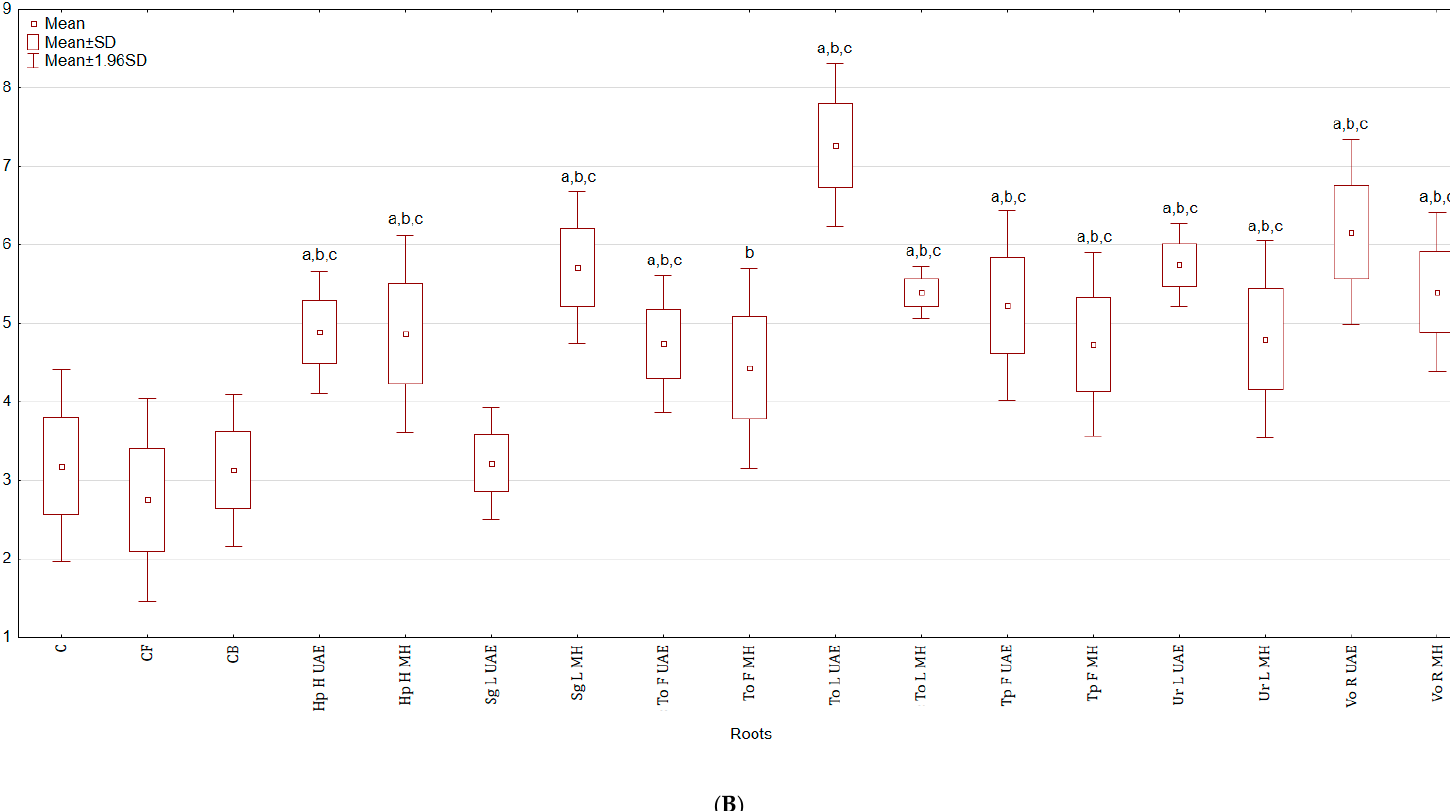
Figure 6. ( A ) Effect of the foliar application of botanical extracts on the antioxidant activity ABTS of celeriac leaves (N = 4). ( B ) Effect of the foliar application of botanical extracts on the antioxidant activity ABTS of celeriac roots (N = 4). (a) Statistically significant differences ( p < 0.05) between the control group (C) and extracts. (b) Statistically significant differences ( p < 0.05) between water formulation (CF) and extracts. (c) Statistically significant differences ( p < 0.05) between commercial biostimulant (CB) and extracts. 1st term of leaves rosette collection—samples taken for analyses 7 days after the second spraying. 2nd term of leaves rosette collection—samples taken for analyses after harvesting. Abbreviations: UAE, ultrasound assisted extraction; MH, mechanical homogenisation; Hp H, Hypericum perforatum L. (St. John’s wort, herb); Sg L, Solidago gigantea Ait. (giant goldenrod, leaf); To F, To L, Taraxacum officinale (L.) Weber ex F.H. Wigg (common dandelion, flower, leaf); Tp F, Trifolium pratense L. (red clover, flower); Ur L, Urtica dioica L. (nettle, leaf); Vo R, Valeriana officinalis L. (valerian, root).